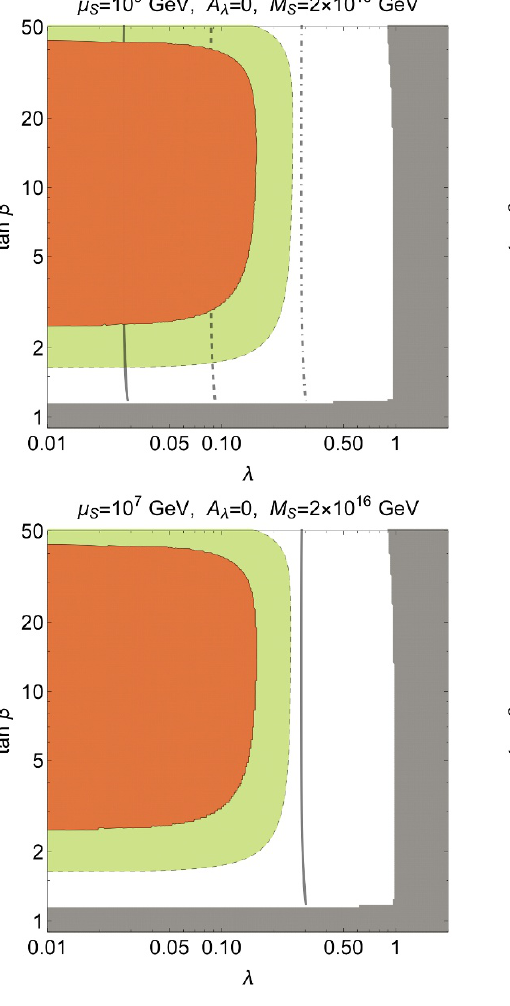
(cid:2) 10 16 S = 2